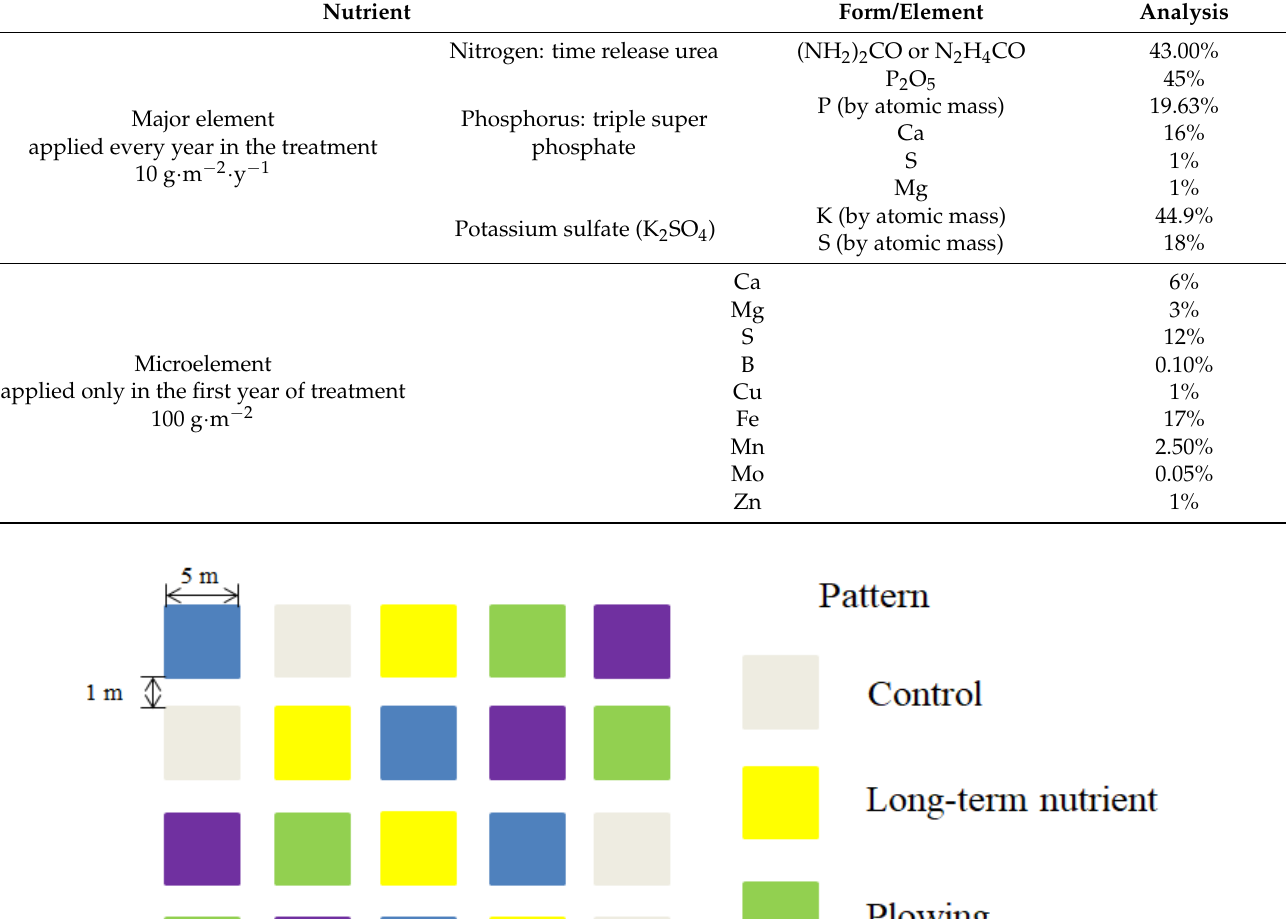
Table 1. Specific formula of the nutrient addition.